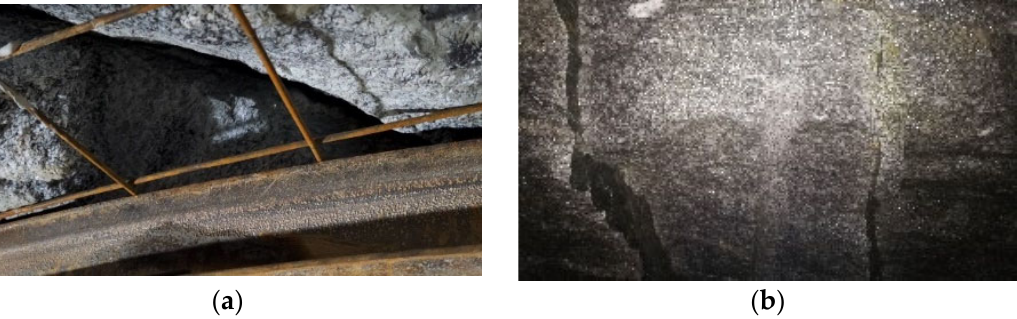
Figure 9. On ‐ site fissures reveal pictures. ( a ) On ‐ site fracture picture 1; ( b ) On ‐ site fracture picture 2. Figure 9. On-site fissures reveal pictures. ( a ) On-site fracture picture 1; ( b ) On-site fracture picture